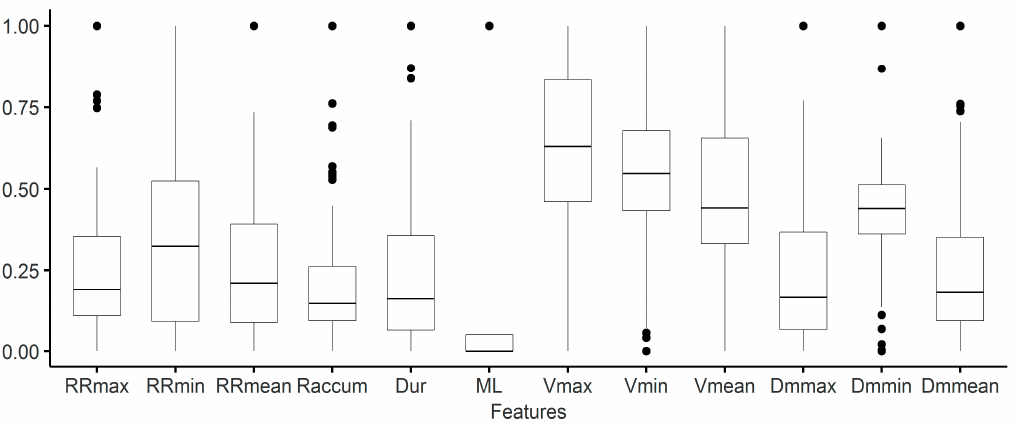
Figure 7. Standardized features using the range method.